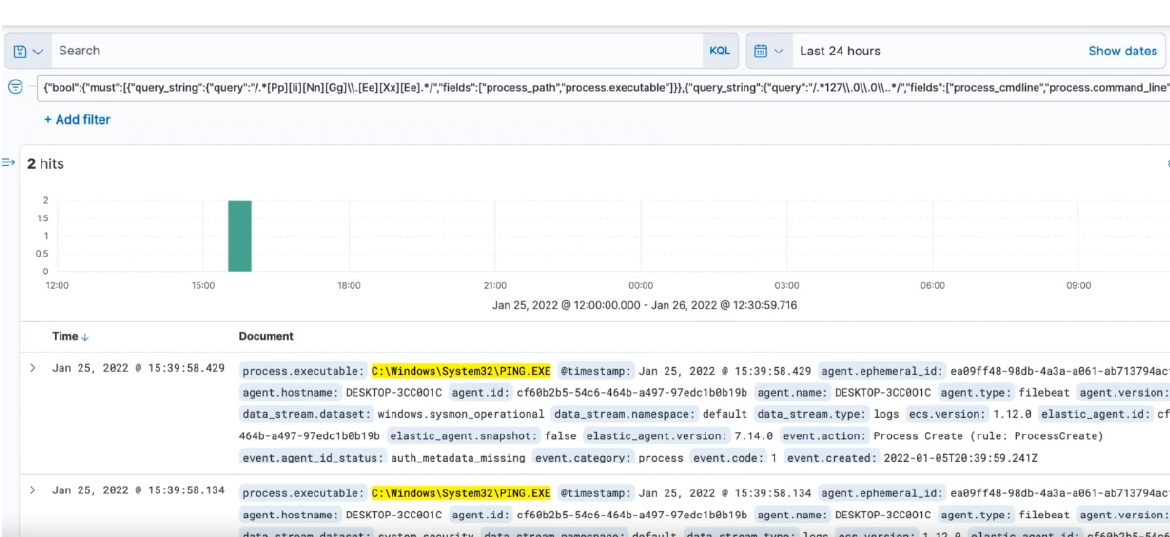
Figure 12. Search results for Ping and Loopback threat vectors.